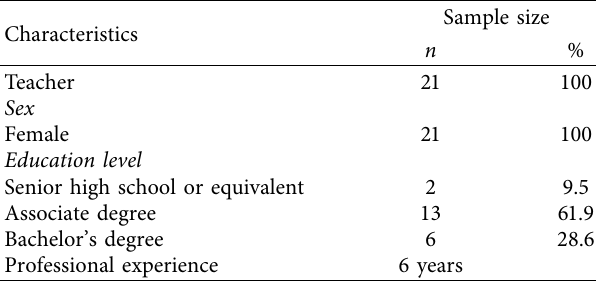
Table 3: Demographic characteristics of teachers in the pilot